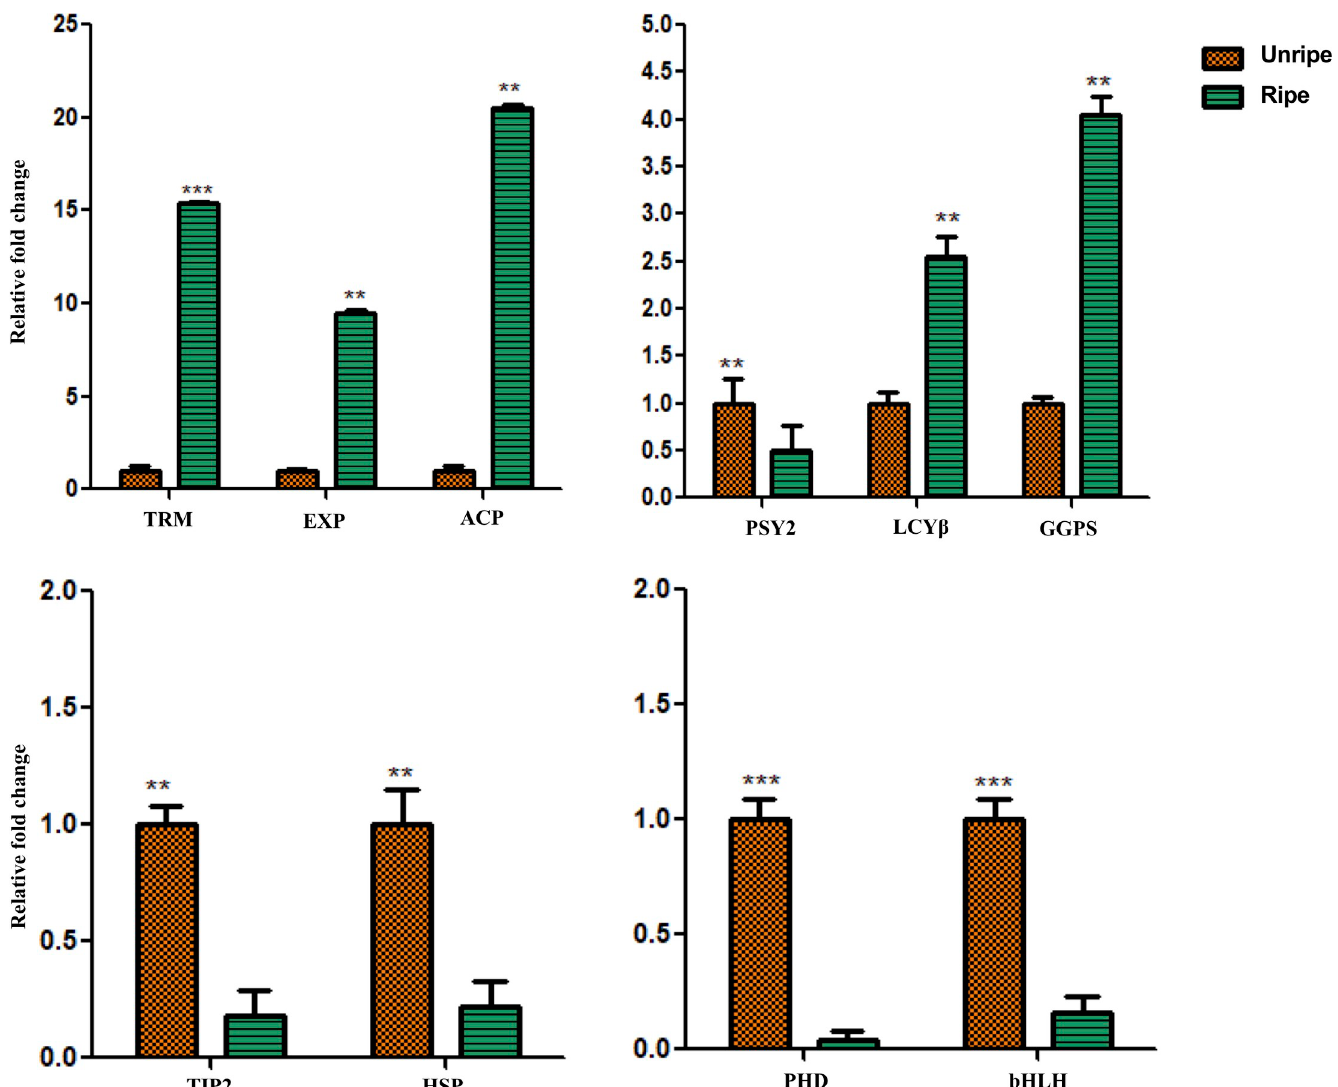
Fig 6. Quantitative real-time PCR of selected genes. Expression profile of selected genes in ripe Nendran banana. Gene expression was normalized using Actin1 as an internal control. Orange bars represent the expression of unripe while green bars depict the expression of ripe genes. Statistical analysis was executed using Student’s paired t-test and statistical significance was checked at �� P � 0.001; ��� P � 0.0001. TRM (Trans-resveratrol di-O-methyltransferase); EXP (Expansin-A2); ACP (Putative 3-oxoacyl-[acyl-carrier-protein] reductase , chloroplastic); PSY2 (phytoene synthase 2); LCY β (lycopene beta cyclase); GGPS (geranylgeranyl pyrophosphate synthase); TIP2 ( Probable aquaporin TIP2); HSP (Heat shock 70 kDa protein 8) ; PHD (PHD-type domain-containing protein) ; bHLH (transcription factor bHLH62) .(Corresponding gene IDs given in S1 Table